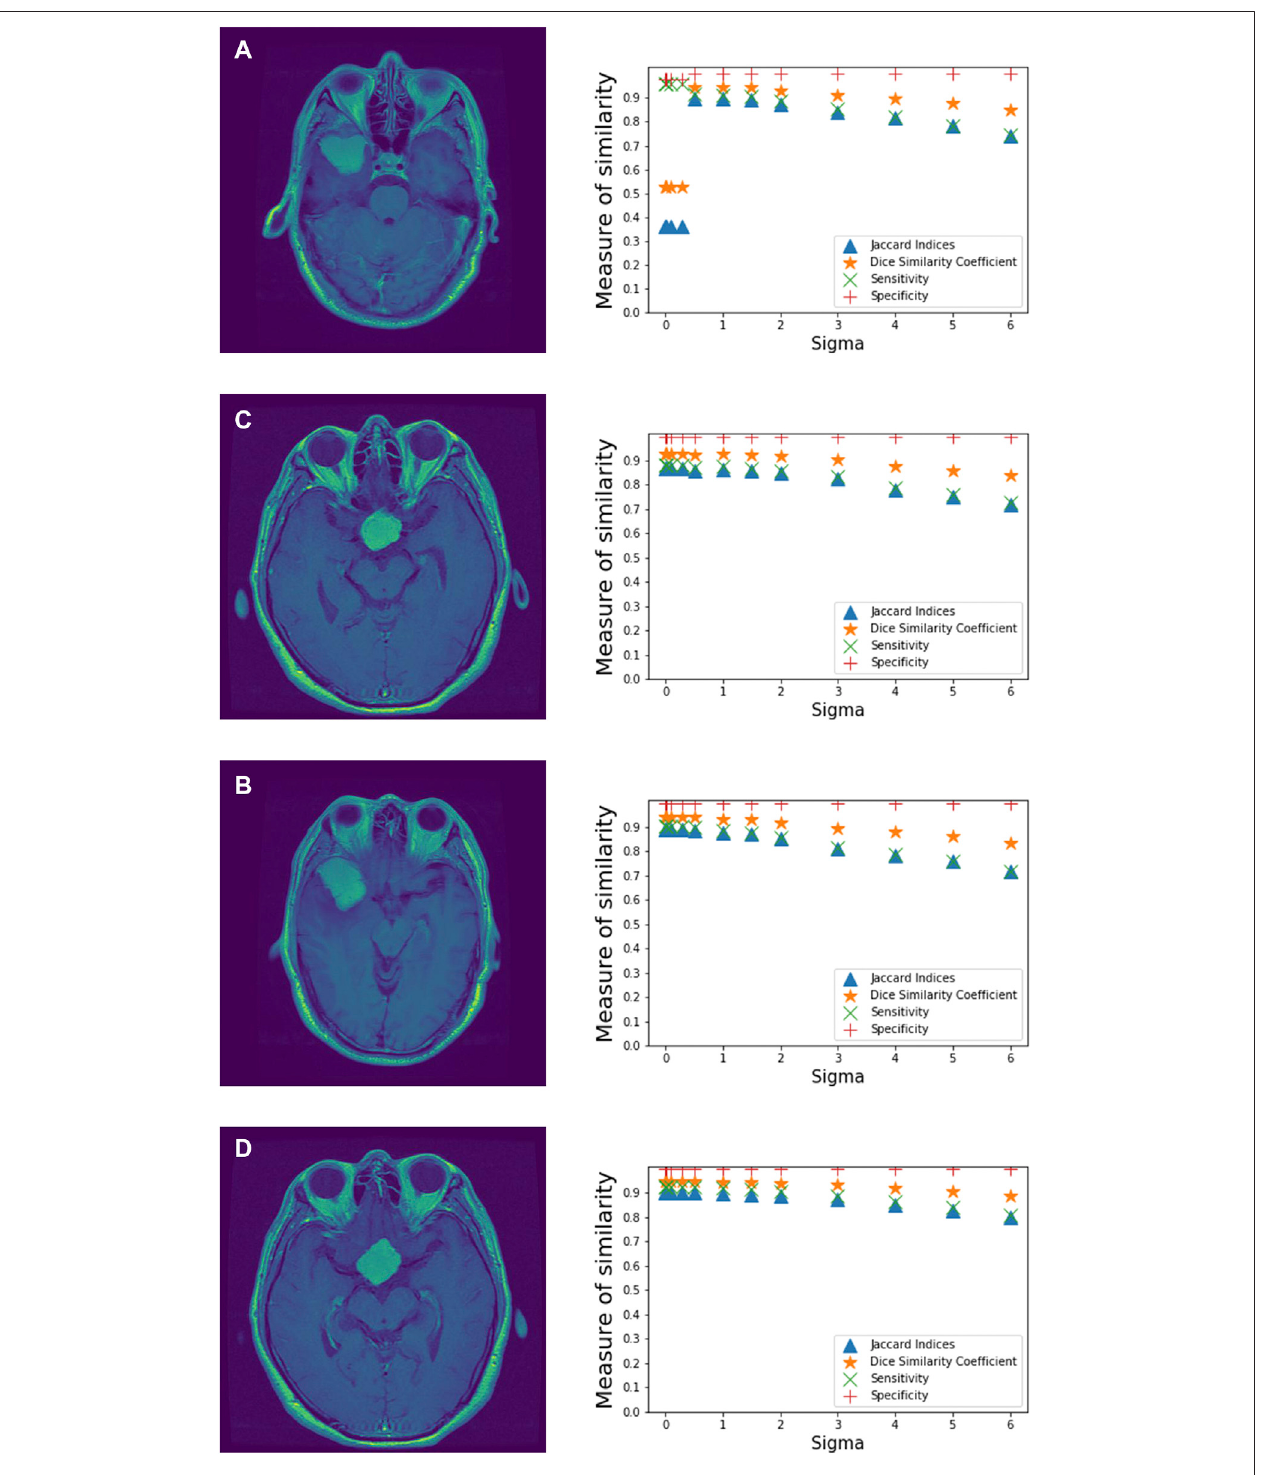
FIGURE9| In fl uenceofsigmaontheperformanceoftheminimumspanningtree-basedmethod. (A – D) Imagesandthecorresponding graphsshowingmeasures of similarity (vertical axis) of the segmented images using the minimum spanning tree method in relation to the tuned sigma (horizontal axis). The sigma values tested include: 0, 0.01, 0.1, 0.3, 0.5, 1.0, 1.5, 2.0, 3.0, 4.0, 5.0, and 6.0.